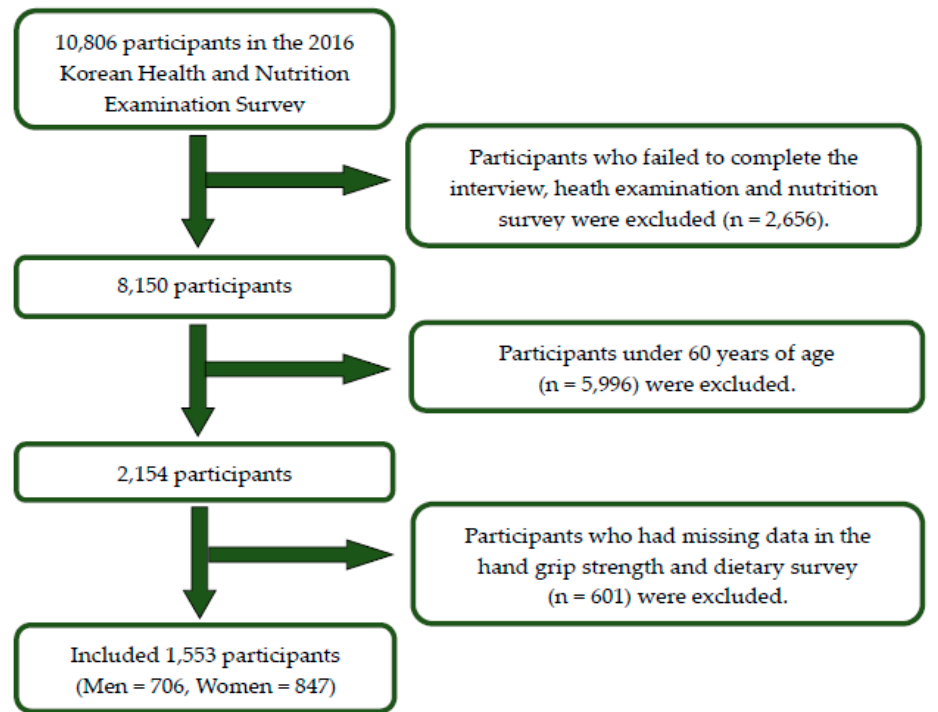
Figure 1. Flow diagram of the study participants.